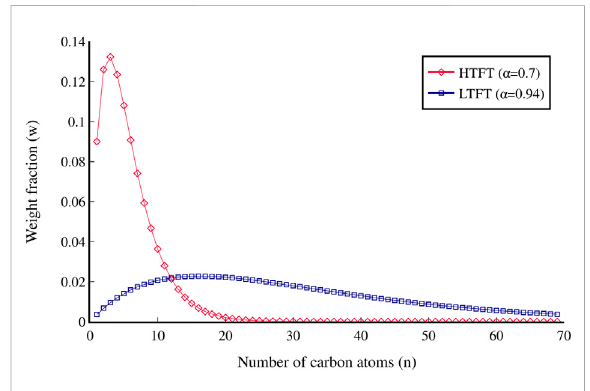
FIGURE 1 Anderson Schulz Flory distribution by weight fraction for alkanes of carbon numbers 1 –